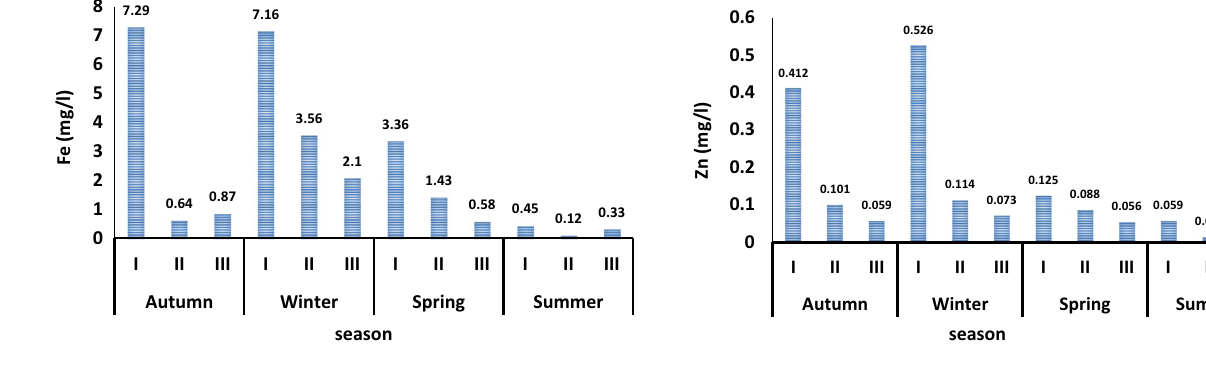
Fig. 2 Fe concentration (mg/L) in water samples from autumn 2018 to summer 2019 along the investigated area